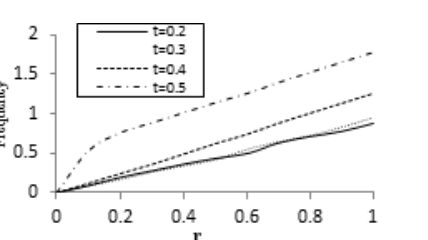
Figure 11: Distribution of frequency with the radius via RPL ℜ =